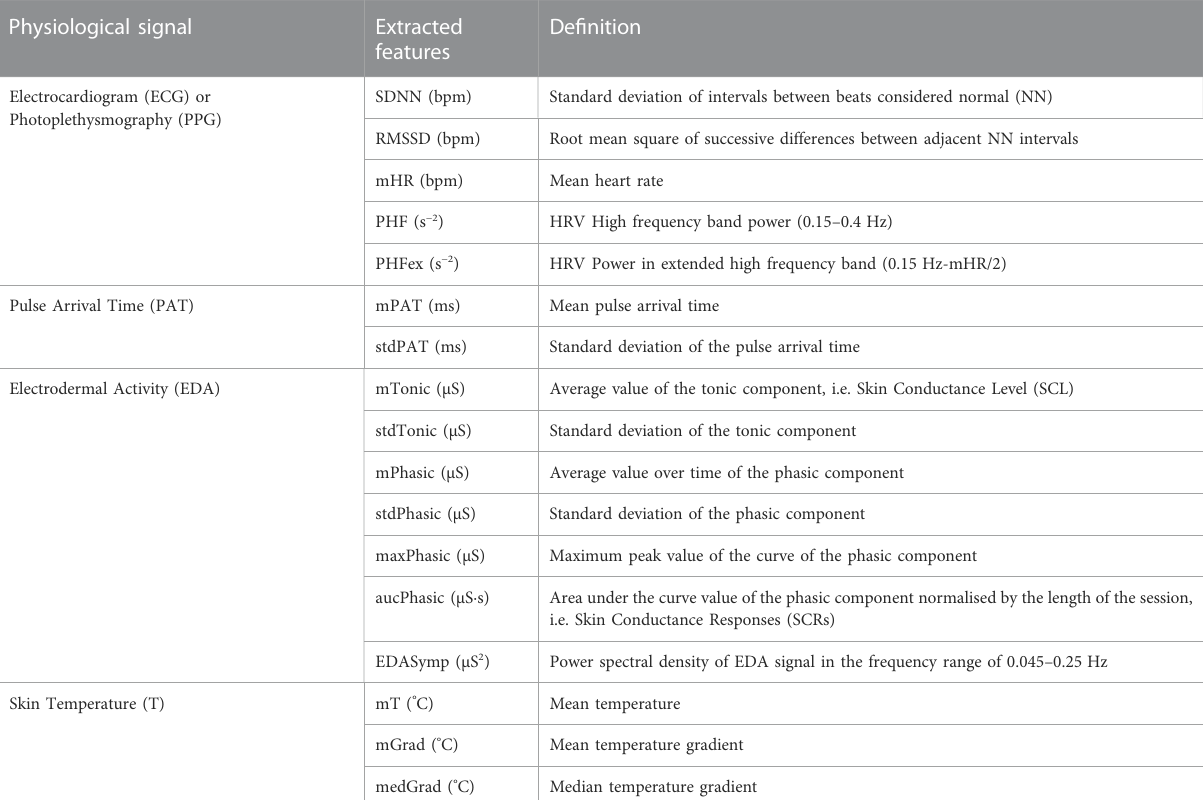
windows of 2 seconds displaced every half-second using the